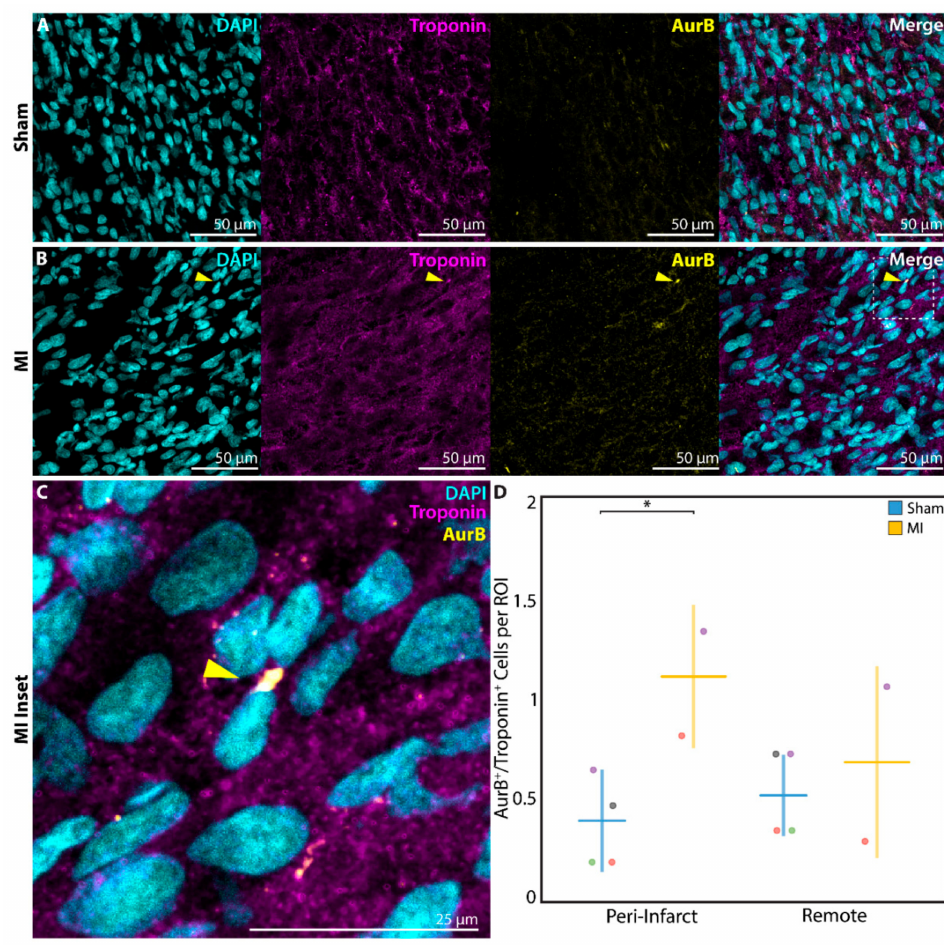
Figure 7. Assessment of cardiomyocyte proliferation using aurora B kinase (AurB) at 1 week after sham surgery ( n = 4) or induction of myocardial infarction (MI, n = 2) on postnatal day 1 (P1). AurB + / troponin + cardiomyocytes were detected within the peri-infarct region after ( A ) P1 sham and ( B ) P1 MI surgery. Inset ( C ) focuses on one AurB + / troponin + cardiomyocyte after P1 MI, marked by the yellow arrow. ( D ) Significantly more AurB + / troponin + cardiomyocytes were detected within each region of interest (ROI) for the P1 MI group compared to the P1 sham group in the peri-infarct region. * indicates p < 0.05. Horizontal lines indicate mean. Vertical lines indicate standard